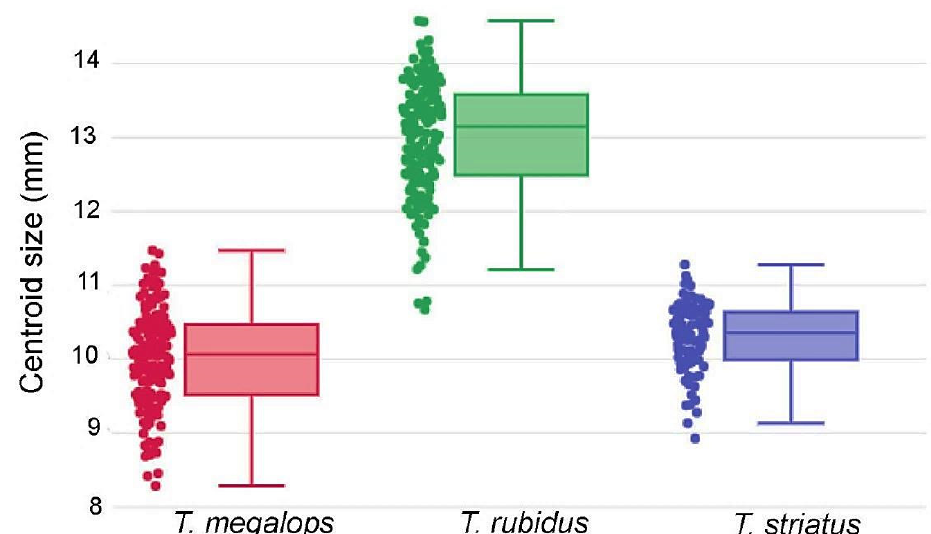
Figure 5. Quantile boxes of centroid size variations of Tabanus megalops (red, leftmost box), T. rubidus (green, central box), and T. striatus (blue, rightmost box). The horizontal line crossing each box is the median separating the 25th and 75th quartiles.